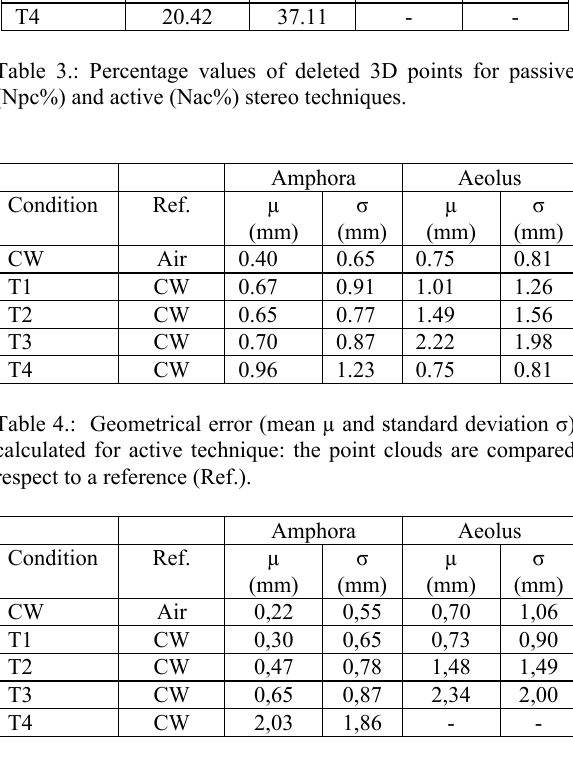
Table 5.: Geometrical error (mean µ and standard deviation σ ) calculated for passive technique: the point clouds are compared respect to a reference